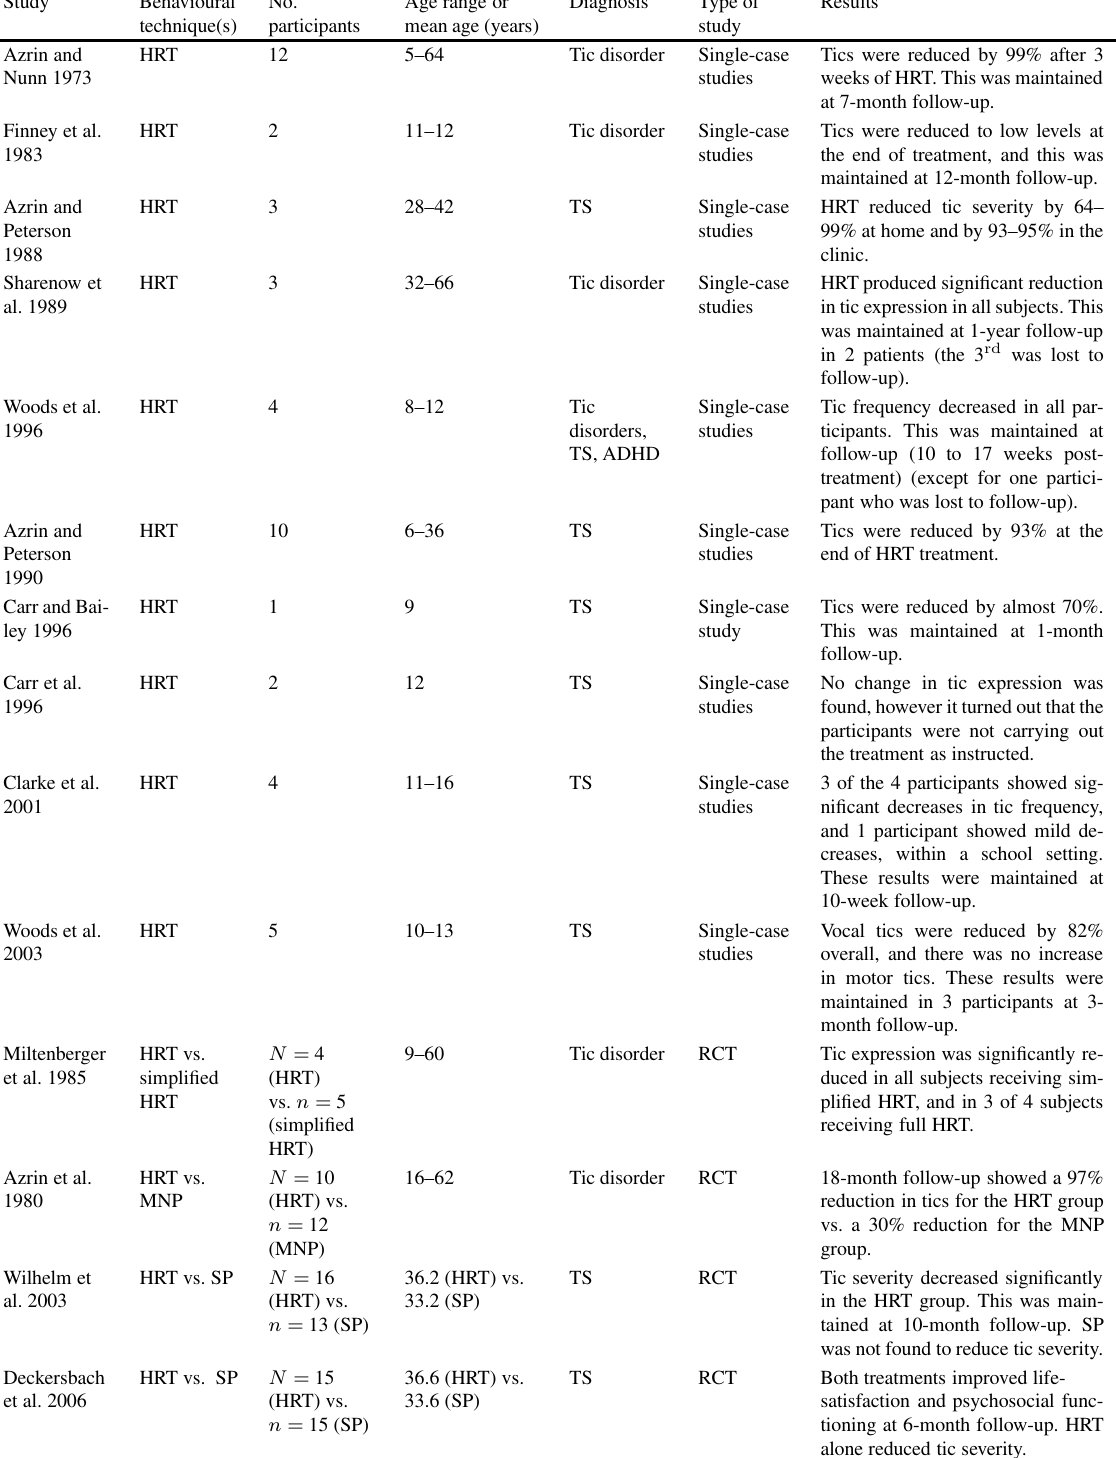
Table 1 Summary of studies using behavioural techniques to treat tic